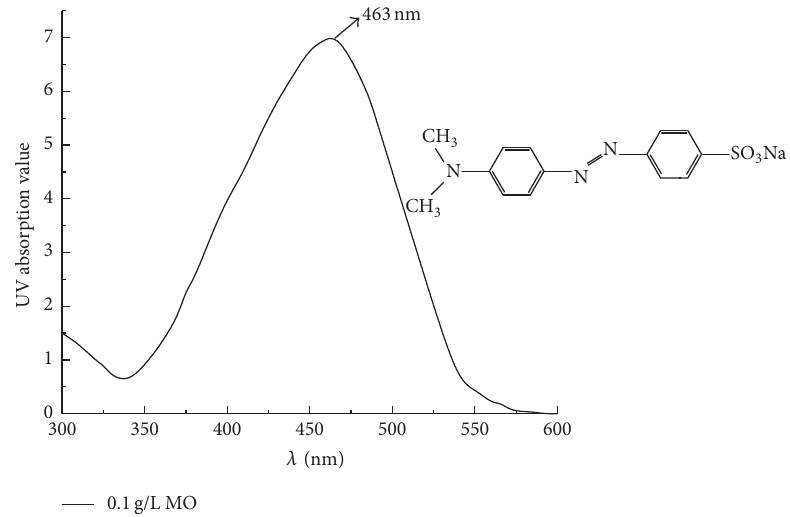
Figure 2: The UV-VIS absorption spectra of 0.1 g/L